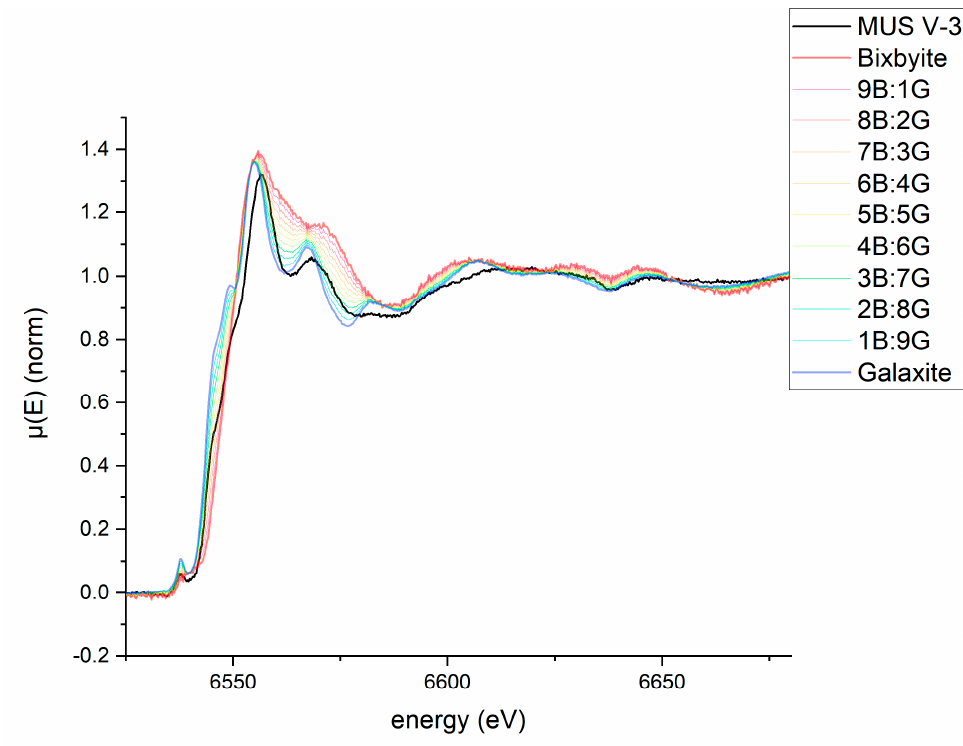
Figure 8. Linear combination of bixbyite (B) and galaxite (G). The spectrum of the MUS is similar to the linear combination. At the edge jump, the MUS spectrum fits the middle of the linear combination, whereas in the region after the edge, the spectrum is more similar to that of galaxite.